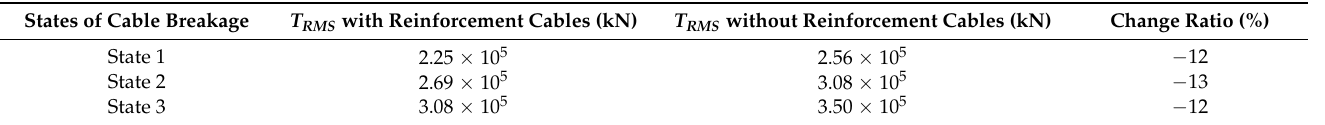
Table 3. Comparison of root-mean-square value results of cable tension response with or without reinforcement cables.